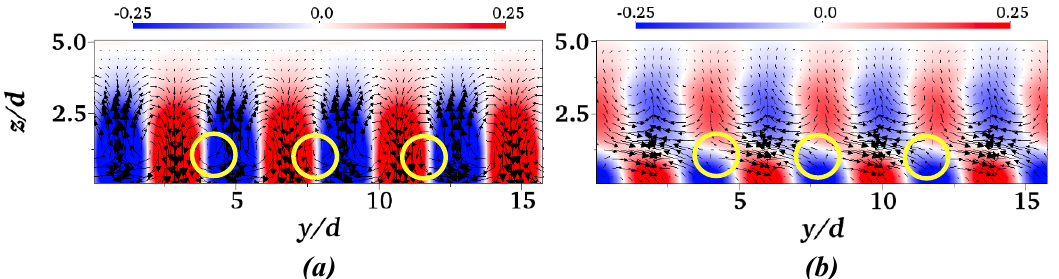
k y d = 0.8. Contours— ˜ φ u , in-plane vectors— ˜ φ v , ˜ φ w ∀